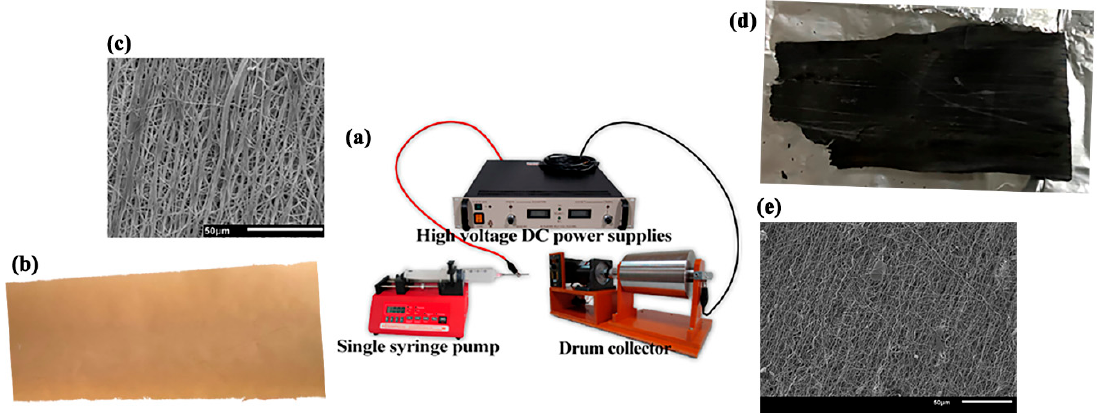
Figure 1. (a) electrospinning apparatus; ( b ) fabricated lignosulfonate fibers; ( c ) fabricated lignosulfonate fibers’ SEM; ( d ) activated carbon fibers; ( e ) activated carbon fibers’